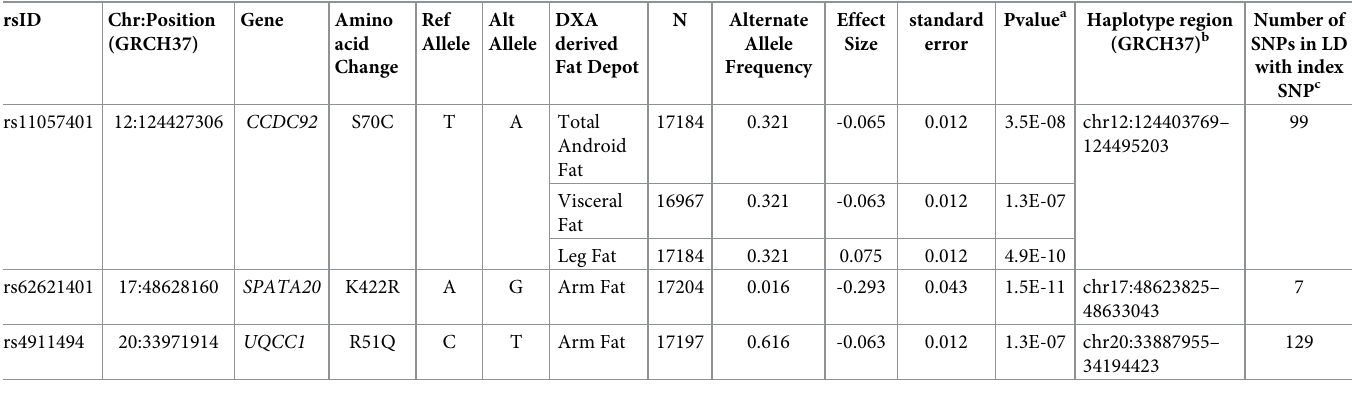
Table 2. Primary exome-wide significant